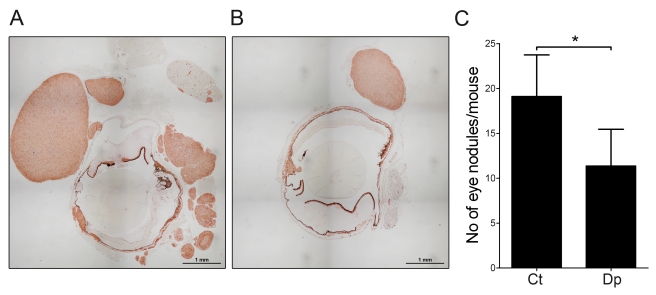
PMN-MDSC favor multinodular growth of the primary tumor.(A and B) Multinodular eye tumors from control (A) and PMN-MDSC depleted (B) mice stained with anti-S100B antibody (depletion scheme A). (C) Number of nodules per mouse. Results are from 11 depleted (depletion scheme A) mice (Dp) and 10 littermates injected with control antibody (Ct). *p value <0.05, two-tailed paired t test.